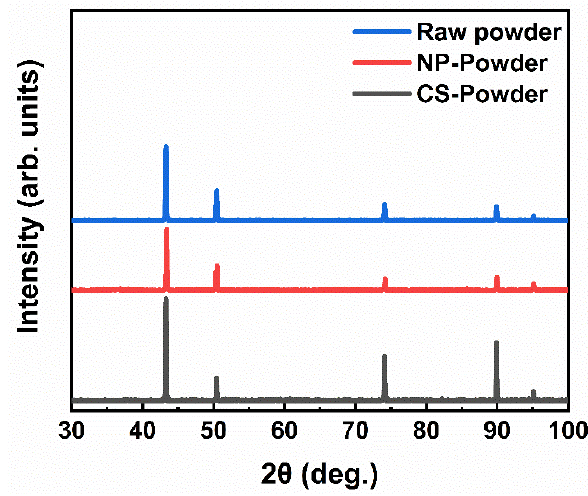
Figure 8. XRD patterns of the raw powder, NP-powder and CS-powder.